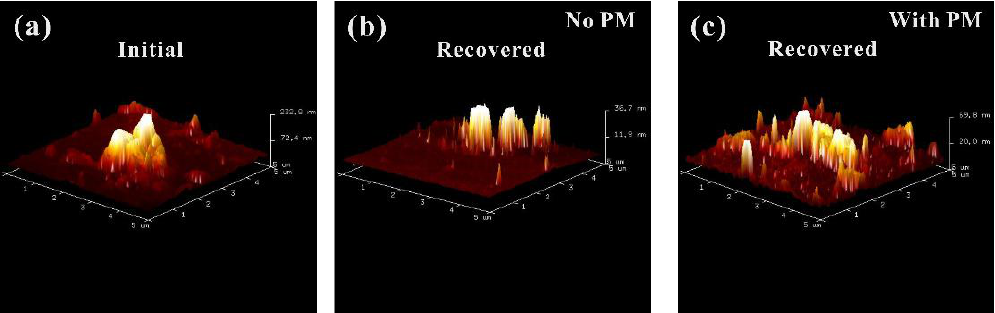
Figure 9. Three-dimensional atomic force microscopy (AFM) images of Ga 2 Se 3 . ( a ) The image of the initial sample; ( b , c ): The images for the recovered samples decompressed from 39.4 GPa under non-hydrostatic conditions and decompressed from 39.6 GPa under hydrostatic conditions, respectively. Here, PM stands for the pressure